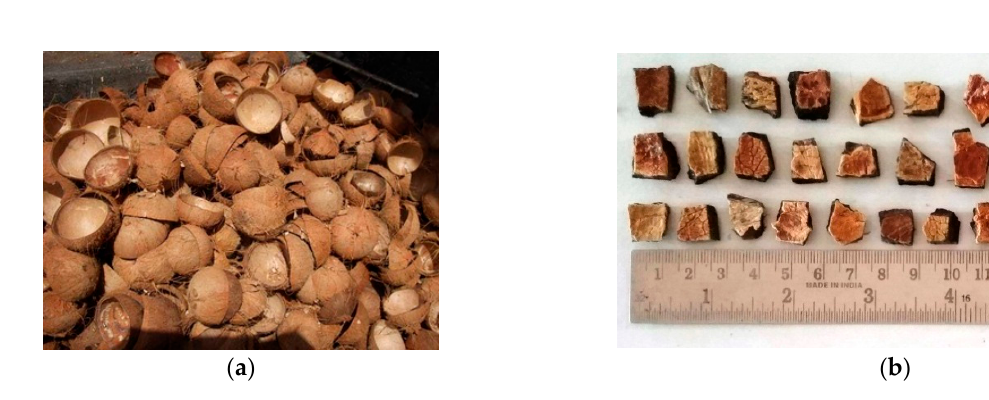
Figure 3. ( a ) Coconut shell and ( b ) coconut shell aggregate.